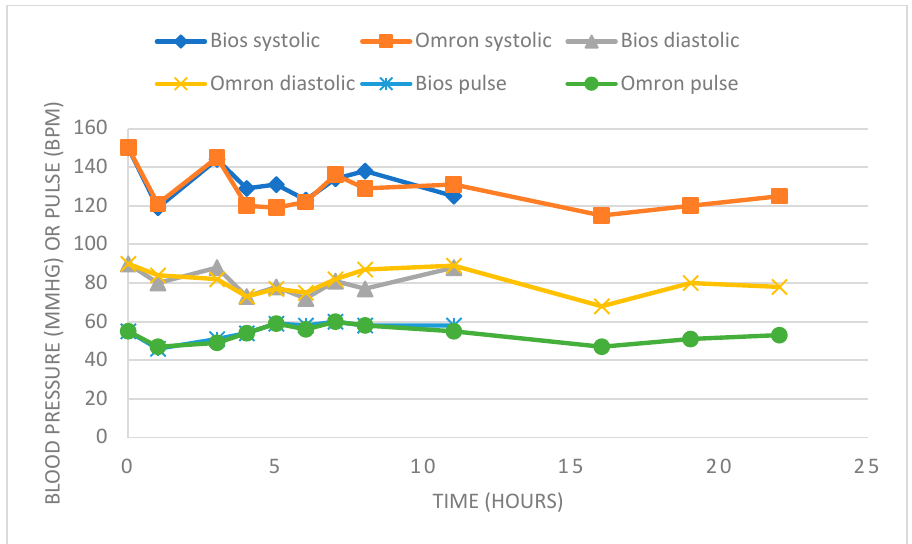
Figure 2. Twenty-four-hour blood pressure measurements beginning at 9 am using two different devices (Bios and Omron).